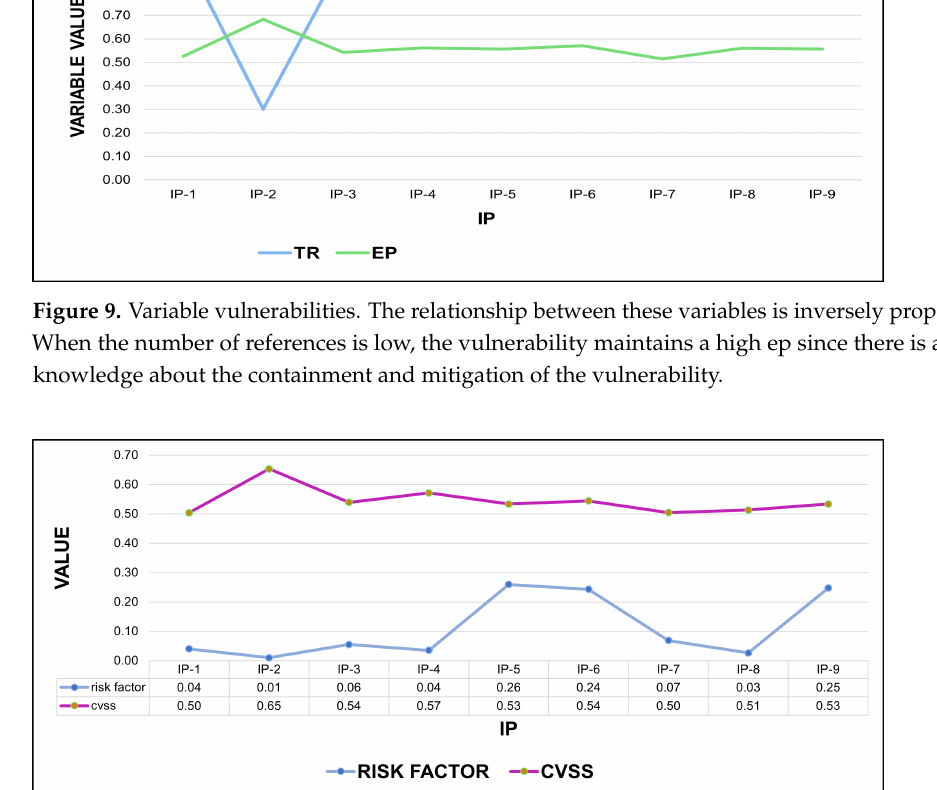
Figure 10. CVSS trend and risk factor by IP. The environment variables evaluated and applied for calculating the rf differ from the value assigned by CVSS to a vulnerability since the additional values mean that a vulnerability does not maintain a total impact on the organization. This graph shows that, even with a high CVSS score, the risk factor can be different; i.e., there is no absolute consistency in prioritizing through